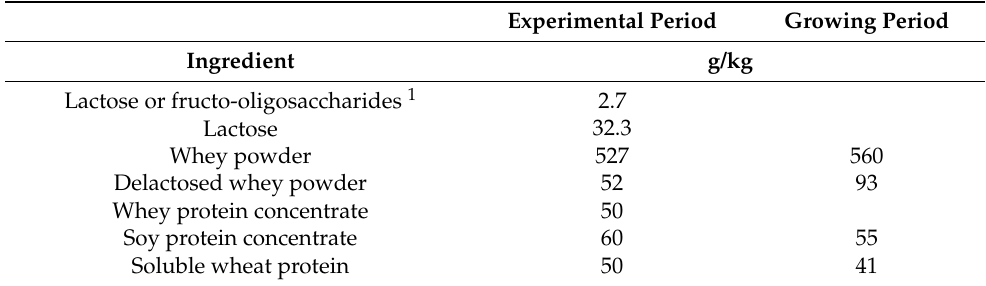
Table 1. Ingredient and nutrient composition of the experimental calf milk